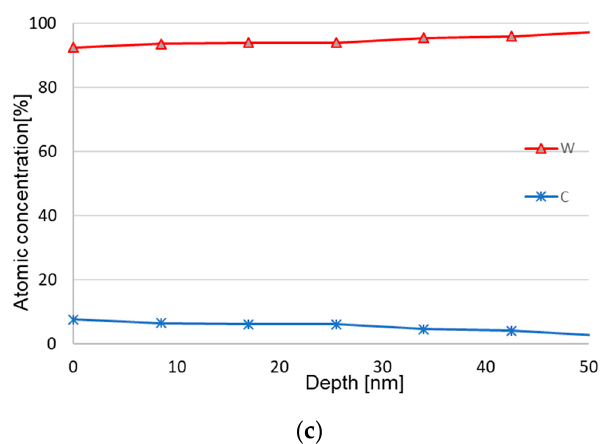
Figure 14. ( a , b ) SEM images of the backside, i.e., the surface in contact with the rake face, of a Ti-6Al-4V chip showing the presence of “islands” containing W-fragments (white fragments in Figure 13b) originating from the diffusion layer. ( c ) AES depth profile of a W-fragment.